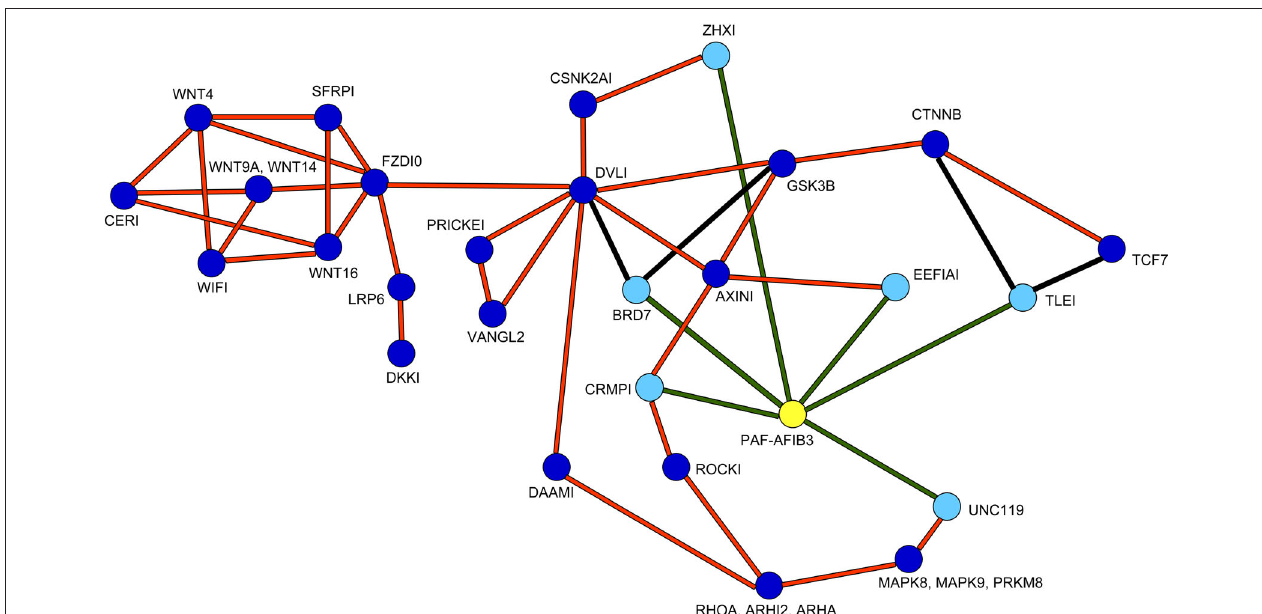
http://141.80.164.19/y2h_network/ppi_search.php (enter official gene symbol: pafah1b3). The BRD7 interactions were added from (Kim et al., 2003), and the interactions between CTNNB, TLE1 or TCF proteins were taken from (Daniels and Weis, 2005), these are marked with black lines.